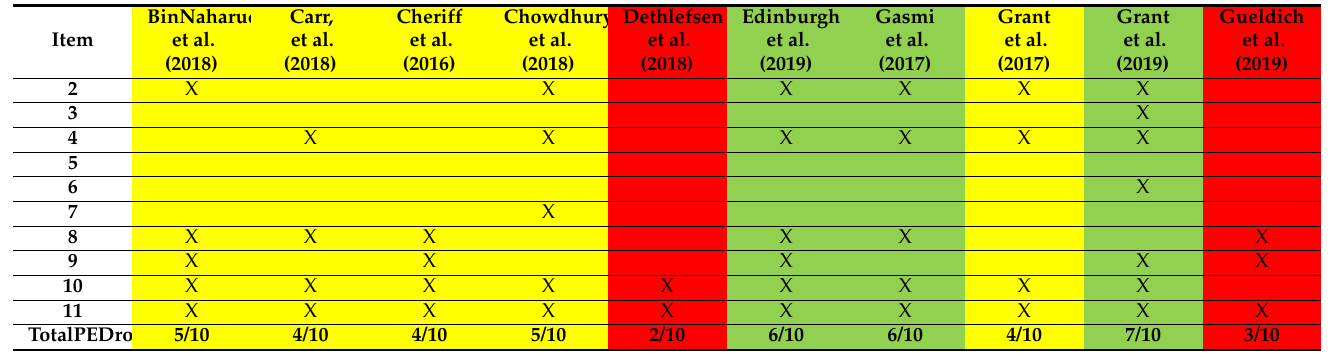
Table 1. Methodological assessment with PEDro scale. Articles 1 to 10.